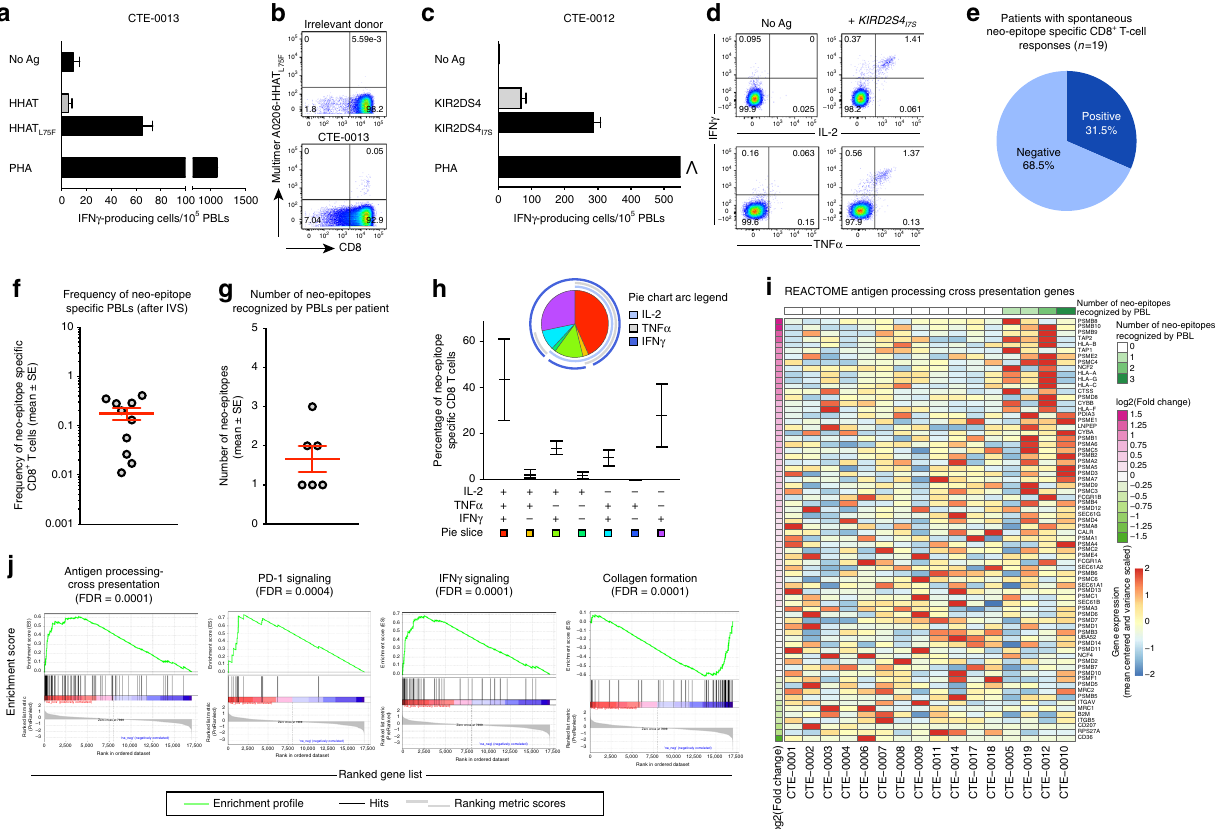
Fig. 1 Identi fi cation of neo-epitope speci fi c PBLs. a , b Representative example of peripheral blood CD8 + T lymphocytes (PBLs) response against the HHAT L75F neo-epitope in patient CTE-0013. a T-cell reactivity measured by IFN γ ELISpot against the neo-epitope (mut) from HHAT L75F gene but not against the wild-type (wt) peptide (PHA: phytohemagglutinin; No Ag: no peptide). Shown are the average of triplicate + SD. b Representative example of validation of neo-epitope speci fi c CD8 + T cells using peptide-MHC multimers. c T-cell reactivity measured by IFN γ ELISpot against the neo-epitope from KIR2DS4 I7S gene but not against the wild-type peptide in patient CTE-0012 (PHA: phytohemagglutinin; No Ag: no peptide). Shown are the average of triplicate + SD. d Representative example of neo-epitope validation by polychromatic intracellular cytokine staining (ICS) in patient CTE-0012 without (No Ag) or after stimulation with a cognate neo-epitope ( KIR2DS4 I7S ). All other PBL neo-epitopes are described in Supplementary Fig. 1 and Table 2. e Proportion of EOC patients with documented peripheral blood CD8 + T-cell (PBL) response against neo-epitopes. f Frequency and g number (mean ± SEM) of neo-epitope speci fi c CD8 + PBLs per patient, detected after one round of in vitro stimulation (Supplementary Table 2). h Cumulative analysis showing the cytokine pro fi les of neo-epitope speci fi c CD8 + PBLs. The SPICE analysis represents the functional composition of cytokine-producing neo-epitope speci fi c CD8 + T cells (mean ± SEM). i Heatmap showing expression of all the genes from Reactome ’ s antigen processing and cross-presentation pathway 53, 54 . The number of neo-epitopes recognized by PBL of each patient is shown on top of the heatmap. Genes from this pathway are ordered based on the differential expression fold change between patients with or without PBL neo-epitope recognition. j Gene set enrichment analysis (GSEA 39 ) curves for various Reactome pathways signi fi cantly different between patients with or without PBL neo-epitope recognition. Vertical bars indicate the ranked positions of each gene from the respective gene set. Statistical signi fi cance of these enrichments is reported by the FDR of the GSEA. Corresponding heatmaps for IFN γ signaling, PD-1 signaling and collagen formation are reported in Supplementary Fig.